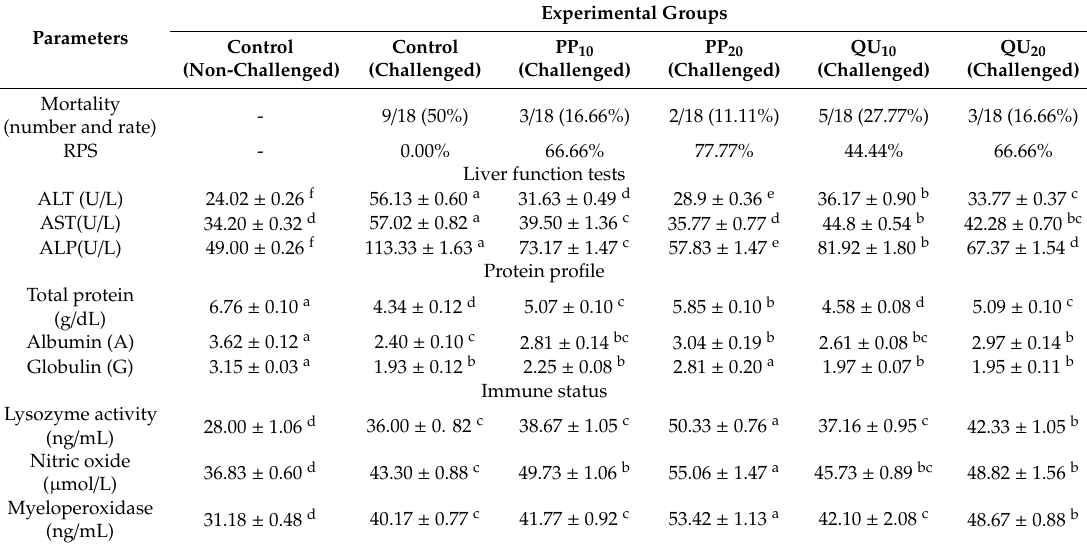
Table 5. E ff ect of the challenge with A. sobria on mortality rate, RPS, liver function and immune status of Nile tilapia supplemented with PP or QU for 45